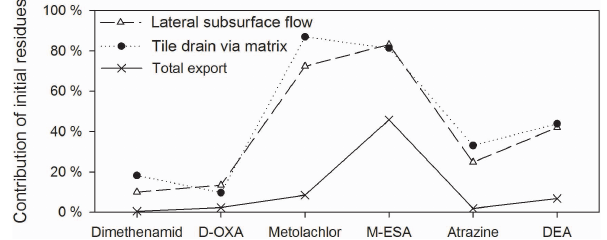
Fig. 4. Modelled contribution of initial residues to substance export pathways at the catchment outlet.